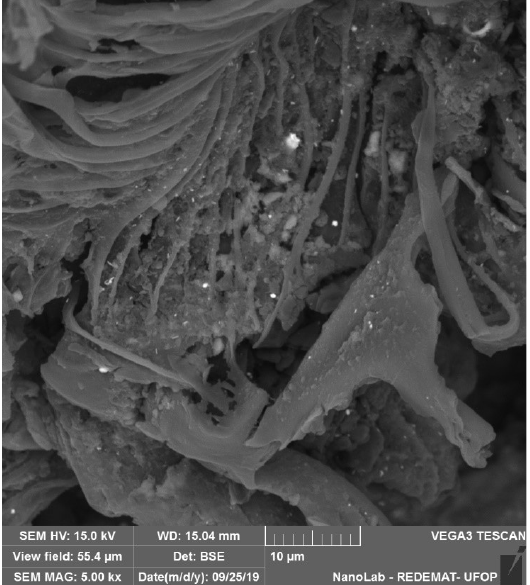
Figure 8. Micrograph of sample AF100-02 tested at 28 days with 5000x